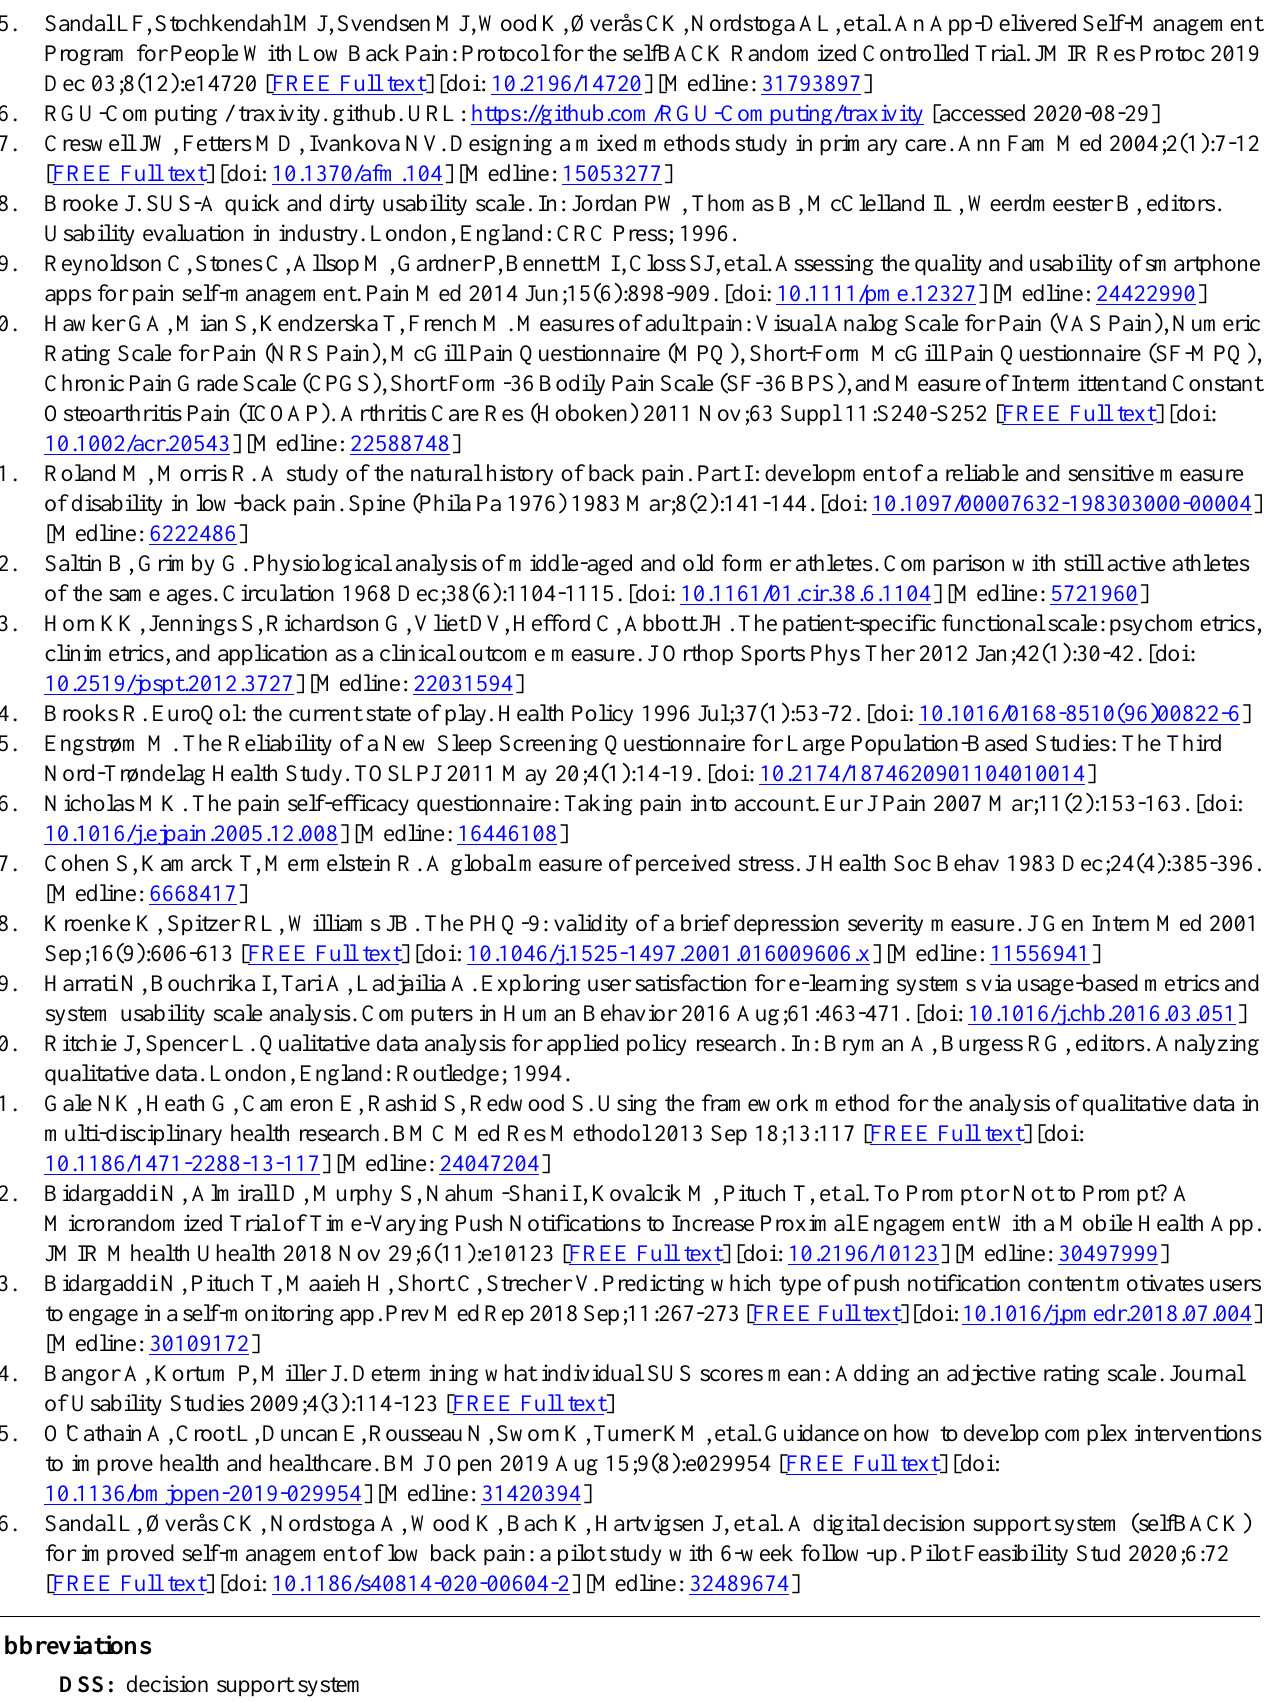
Abbreviations DSS: decision support system EQ-5D: Euroqol 5-D (health-related quality of life) LBP: low back